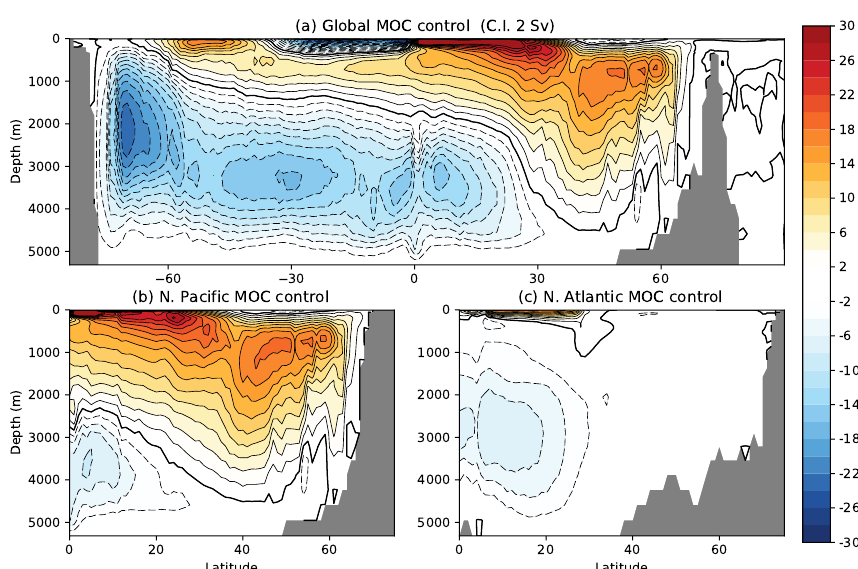
Figure 7. (a) Global meridional overturning circulation (MOC), with the Northern Hemisphere MOC split into (b) Pacific Basin and (c) At- lantic Basin.